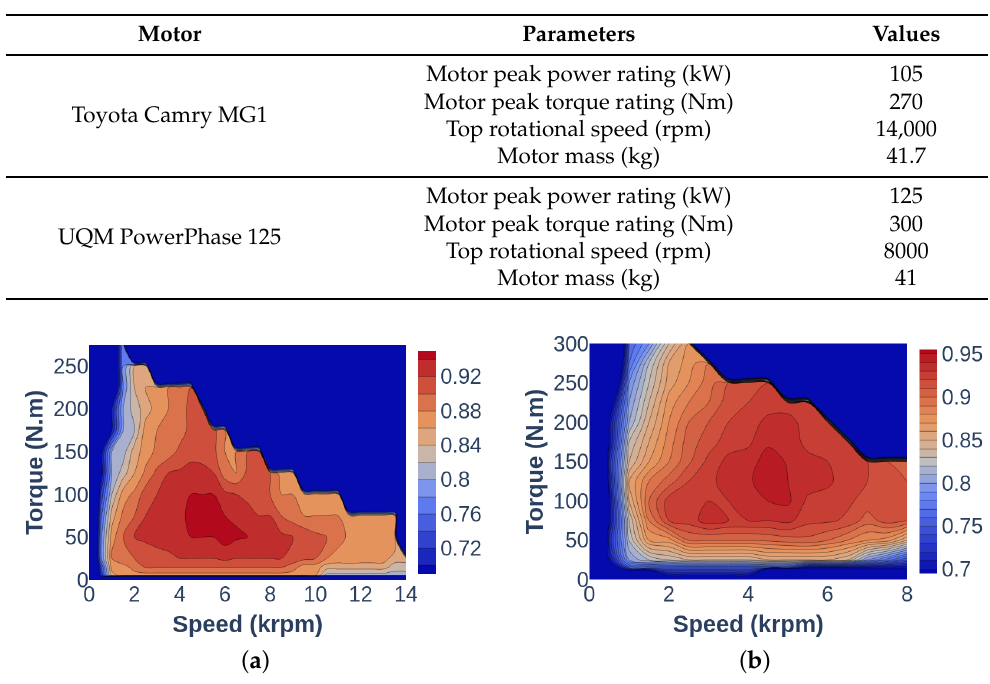
Table 2. Parameters of the motors.